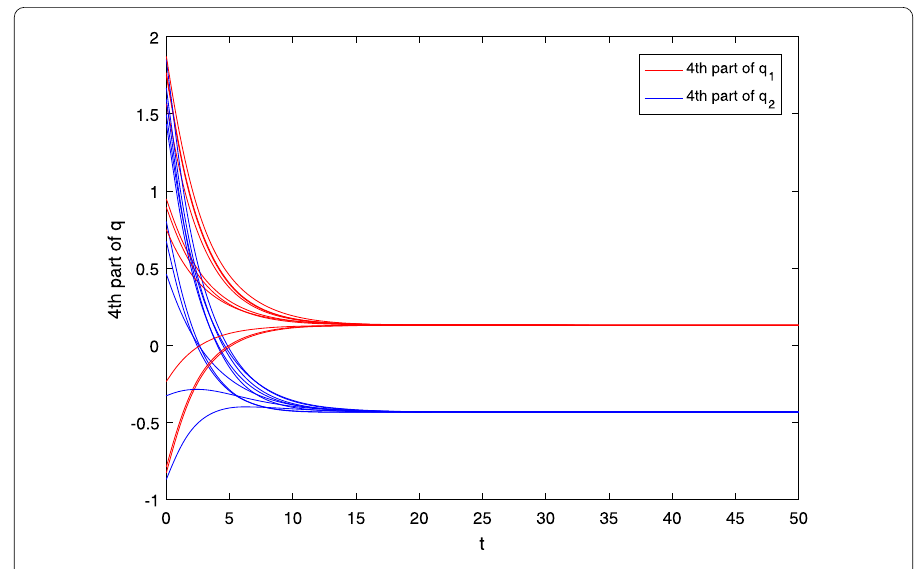
Figure 4 The fourth part of the state trajectories for system (1) with parameters (27)